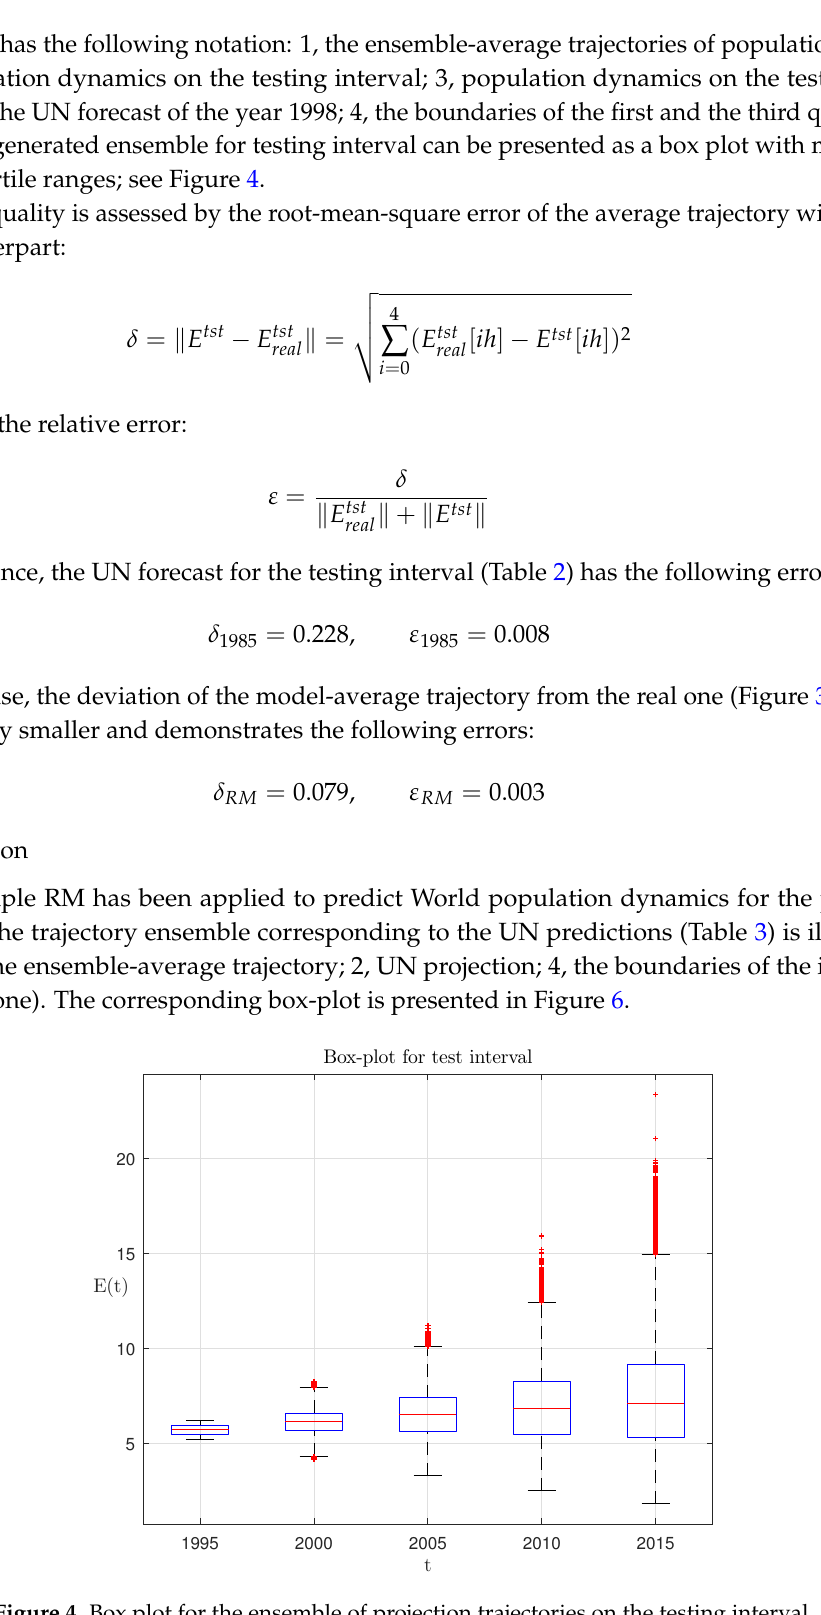
Figure 4. Box plot for the ensemble of projection trajectories on the testing